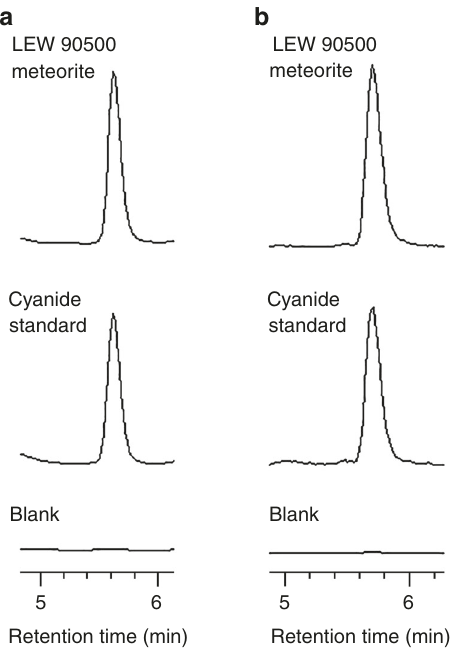
Fig. 1 Identi fi cation of cyanide released from CM chondrites. a Fluorescence chromatograms ( λ ex 252 nm, λ em 483 nm) of naphthalene-2,3- dicarboxaldehyde-cyanide derivative from the LEW 90500 meteorite, KCN standard, and method blank. b Extracted ion chromatograms ( m / z 251.08 with a ±0.03 window; [M + H] + ) of naphthalene-2,3-dicarboxaldehyde- cyanide derivative from the LEW 90500 meteorite, KCN standard,